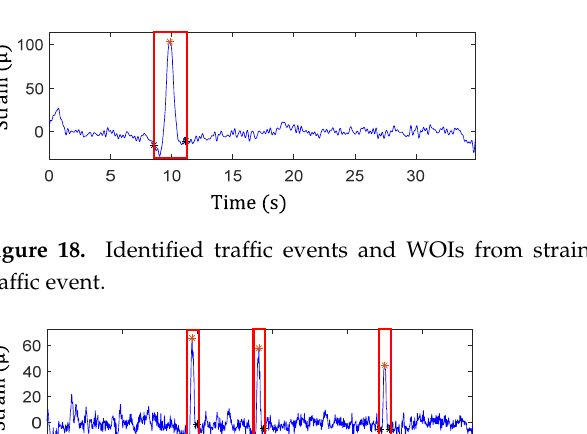
Figure 21. Peak identification within the identified WOIs under the multiple traffic events for ( a ) strain, 𝐹(𝑡) , measurement, and ( b ) ∆𝐶(𝑡) from SEC. 5.4.2. The Modified CGI for Fatigue Crack Monitoring (Step 3) The modified CGIs for the selected fatigue crack are presented here. Utilizing several acceleration thresholds ranging from 150 mg to 250 mg for event-triggered sensing, data from the bridge were collected using the WLASS from mid-October 2021 to mid-March 2022. A total of 129 datasets were used under the aforementioned strain threshold of ℎ = 30 𝜇𝜀 and minimum peak distance of 𝑡 (cid:3031) = 1.3 s defined for peak detection in Step 1 to ob- tain the modified CGIs, which contain 267 impulse peak events. The modified CGIs for both cases were computed for each impulse peak event using Equation (8) based on the WOI. The identified CGIs over the monitoring period for both cases are shown in Figure 22. Note that each data point in the figure shows the mean modified CGI, CGI(cid:3364)(cid:3364)(cid:3364)(cid:3364)(cid:3364) , and the associated standard deviation from impulsive traffic events collected from one to two days with a minimum of two events. For both cases, despite some fluctuation possibly attributed to sensor and data acquisition noise and limited data points, the CGI(cid:3364)(cid:3364)(cid:3364)(cid:3364)(cid:3364) stayed al- most constant, indicating the crack size remained constant during the monitoring period. Moreover, the number of peaks for each CGI(cid:3364)(cid:3364)(cid:3364)(cid:3364)(cid:3364) data point in Figure 22 is shown in Figure 23. As shown in the figure, 19 November 2021, 4 March 2022, and 16 March 2022 recorded the highest number of peaks, including 26 , 68 , and 23 peaks, respectively. For Case-1, the cor- responding CGI(cid:3364)(cid:3364)(cid:3364)(cid:3364)(cid:3364) are 0.017 , 0.015 , and 0.016 , respectively, and the standard deviations are 0.0045 , 0.004 , and 0.004 , respectively. For Case-2, the CGI(cid:3364)(cid:3364)(cid:3364)(cid:3364)(cid:3364) are 0.018 , 0.015 , and 0.017 , re- spectively, and the standard deviations are 0.004 , 0.0035 , and 0.005 , respectively. Note that those means and standard deviations remained almost constant, indicating no crack growth during the monitoring period.